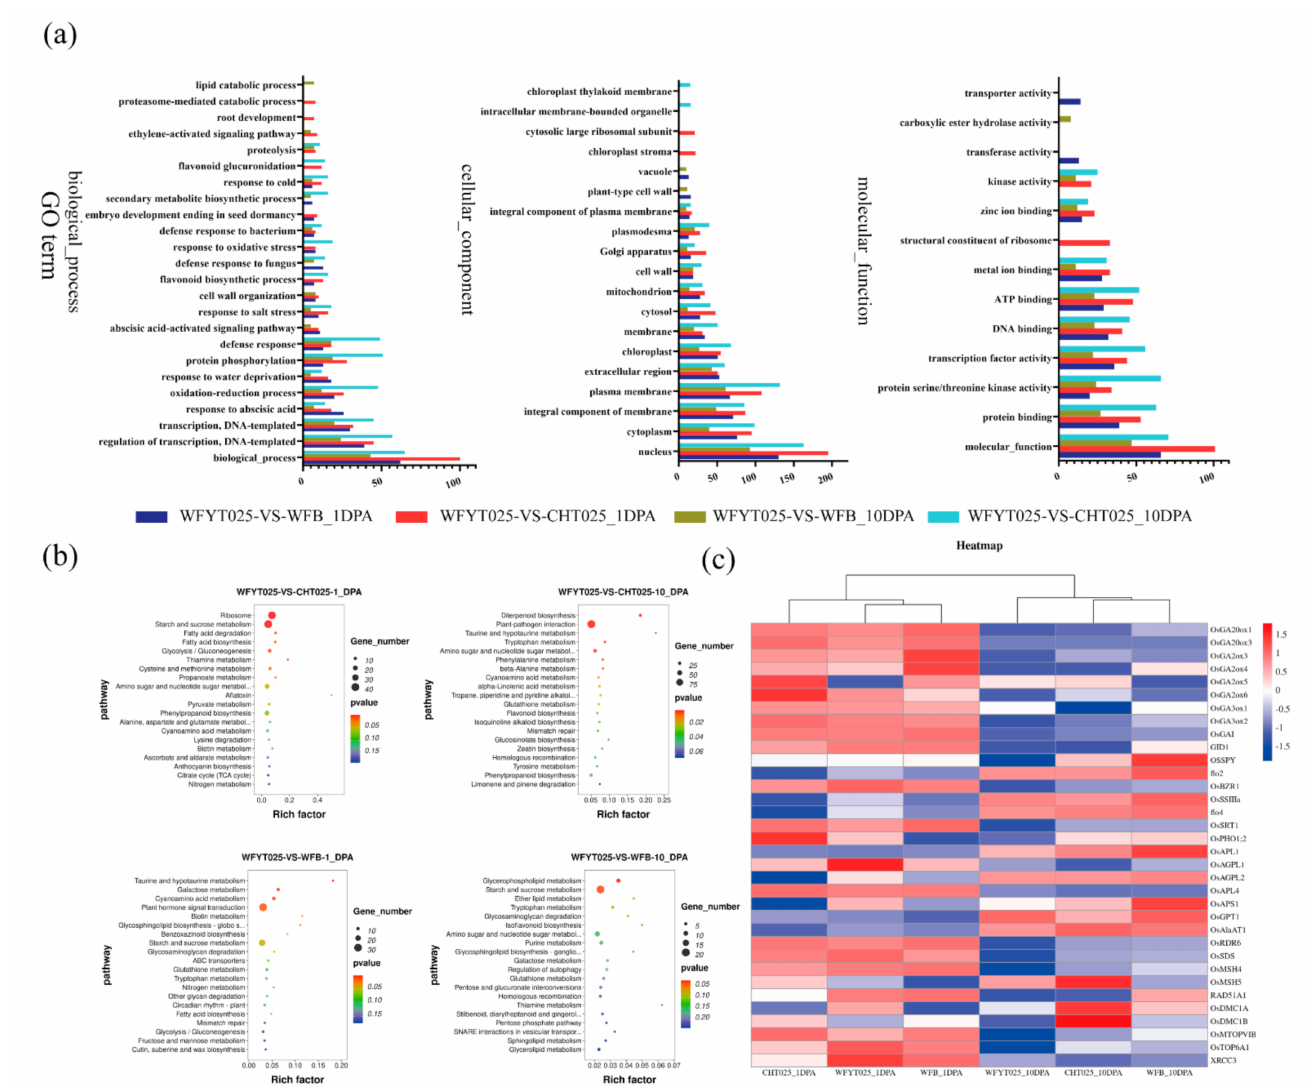
Figure 5. Functional classification of DGHPs through GO and KEGG approach analysis. ( a ) Compari- son of GO classifications of DGHPs. ( b ) KEGG pathway assignments of DGHPs. ( c ) Transcript levels of related genes and genes involved in GA, starch synthesis, and meiotic biosynthesis pathways during the grain-filling stage. Actin was used as the loading